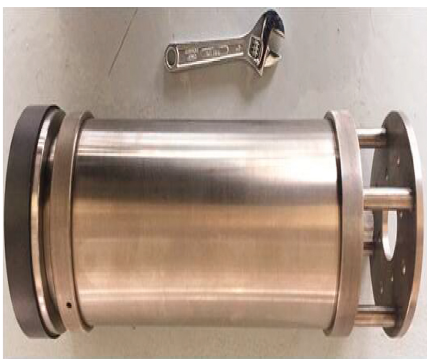
Figure 7: Parametric array equipment used for sea trials.